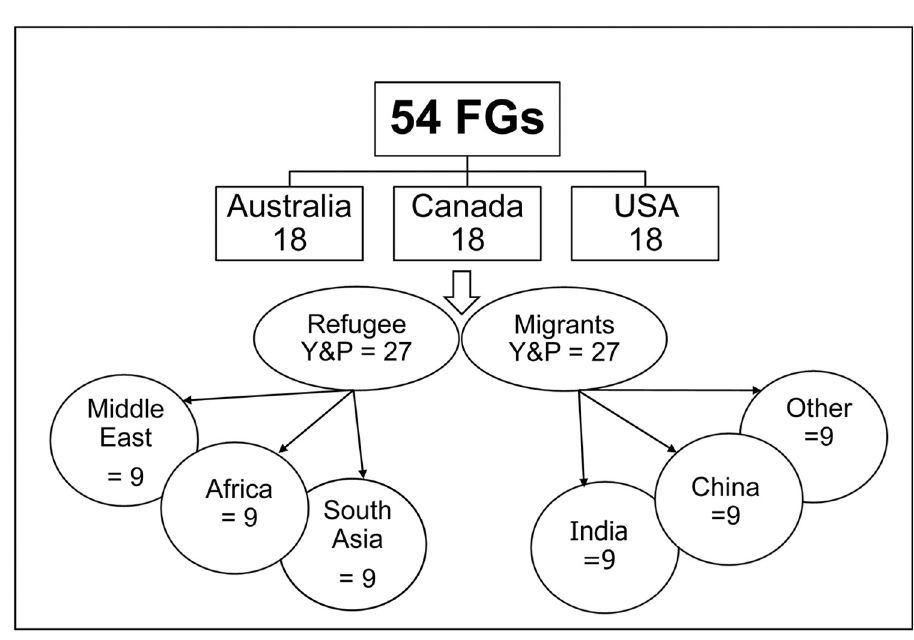
Fig 2. Design of the focus group (FG)